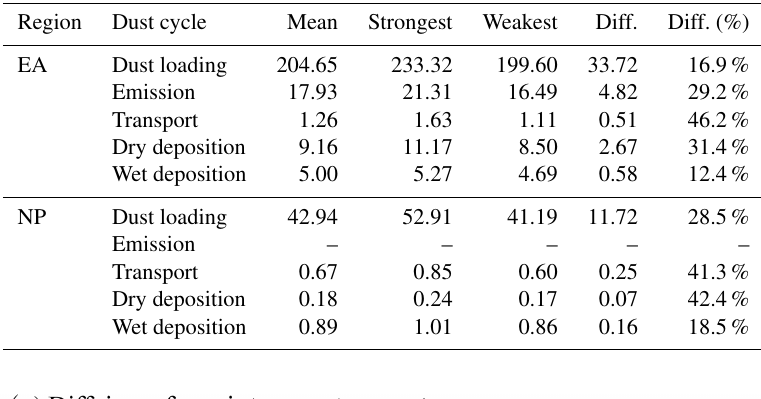
Table 2. The MAM dust cycle including dust loading (mgm − 2 ), dust emission (gm − 2 per season), dust transport (gm − 1 s − 1 ), dust dry deposition (gm − 2 per season), and dust wet deposition (gm − 2 per season) over the East Asian dust source region (EA; 30–43 ◦ N, 76– 110 ◦ E) and over the northwestern Pacific (NP; 35–45 ◦ N, 140–162 ◦ E) from the model in the mean, strongest, and weakest years, as well as the absolute difference (strongest–weakest) and the relative difference ((strongest–weakest) / weakest · 100%).